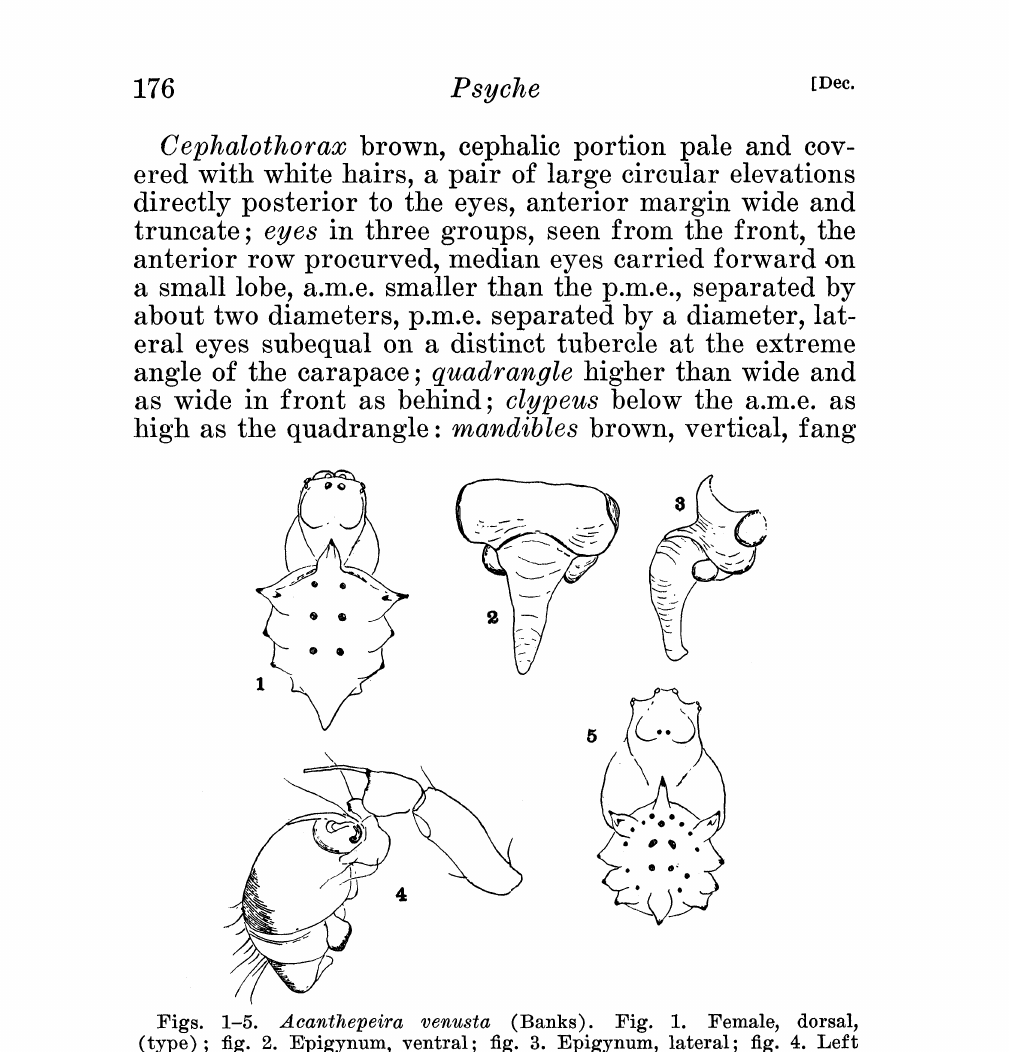
Figs. 1-5. Acanthepeira venusta (Banks). %’ig. 1. ’emale, dorsal, (type); fig. 2. Epigynum, ventral; fig. 3. Epigynum, lateral; fig. 4. Left palpus, retrolateral; fig. 5. Male,